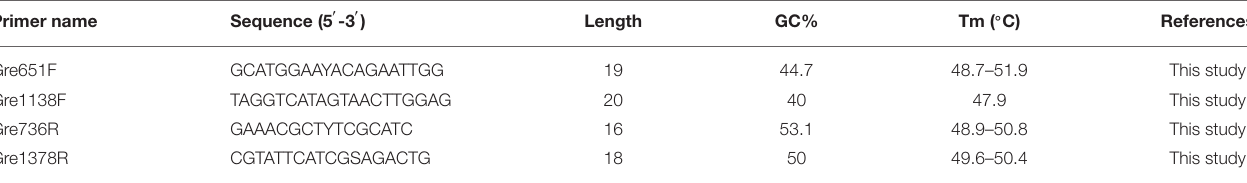
TABLE 1 | Primers newly designed for targeting 18S regions of rRNA genes in